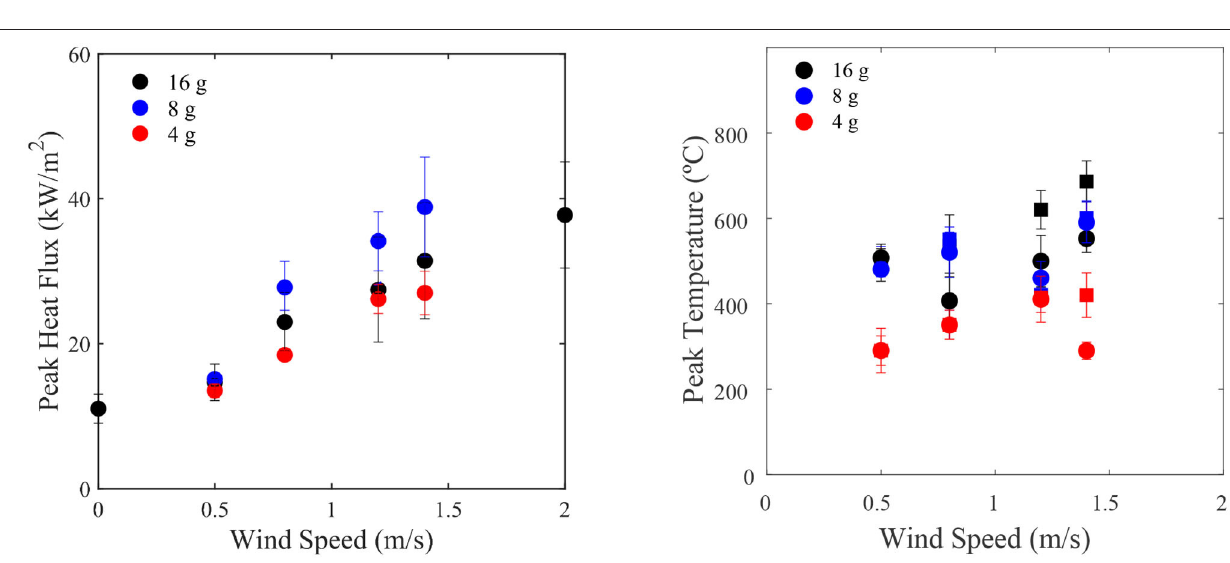
FIGURE 7 | Peak heat flux (left) and peak temperature (right) as a function of wind speed for three pile sizes. For most pile sizes, peak heat flux and temperature increases with increasing wind speed. Peak temperatures are shown for inner TSCs (squares) and outer TSCs